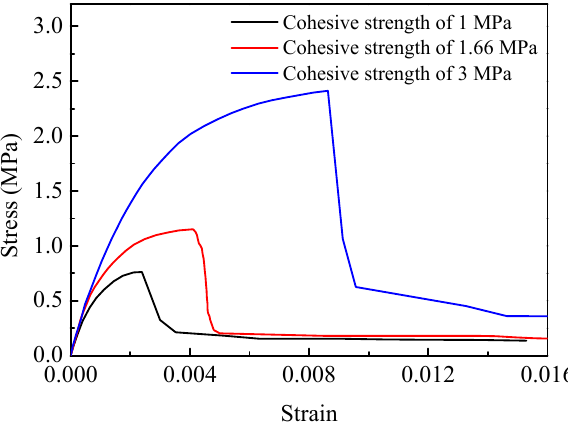
Figure 17. Tensile stress–strain curves of PBX 9501 with different interface strengths at a strain rate of 10 − 3 s − 1 .